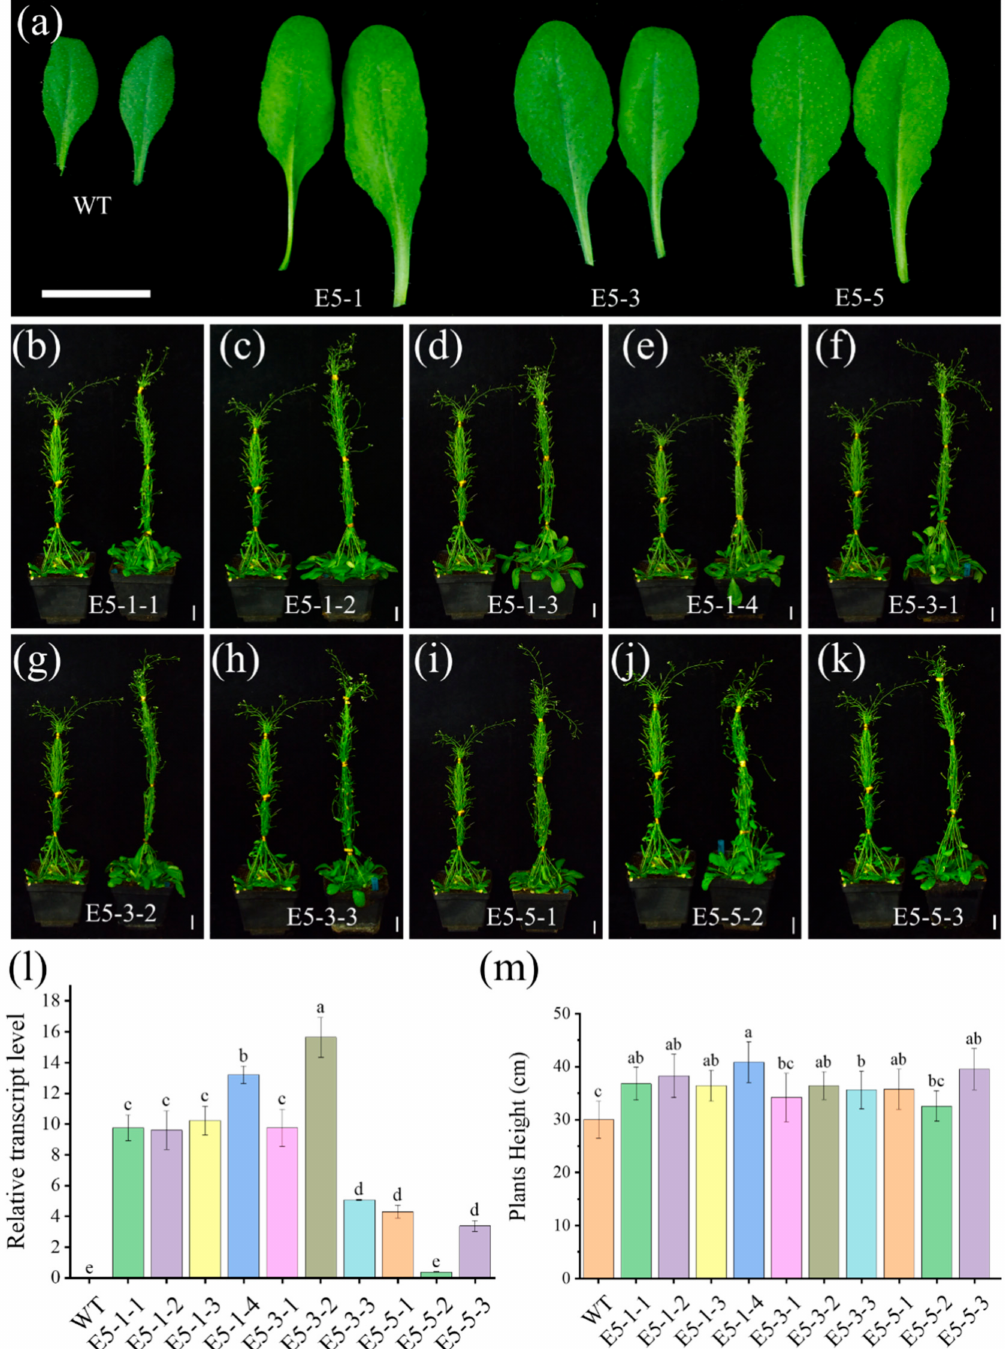
Figure 6. Phenotypic analysis of BnaEXPA5 transgenic Arabidopsis thaliana plants. ( a ) Morphology of the two largest leaves from transgenic lines and WT (wild type), Bar = 2 cm. ( b – k ) Comparison of plant height between WT (left in each image) and transgenic plants (right in each image), Bar = 1.5 cm. ( l ) Relative transcript levels of the BnaEXPA5 from the stems of transgenic plants. The gene AtUBQ5 served as a reference. Values are mean ± SD ( n = 3). ( m ) Comparison of the plant heights of the WT and BnaEXPA5 -transgenic plants. Values are indicated as mean ± SD ( n > 4). Different lowercase letters denote significant differences among the plant lines ( l , m ) ( p < 0.05, one-way ANOVA followed by Tukey’s test for multiple